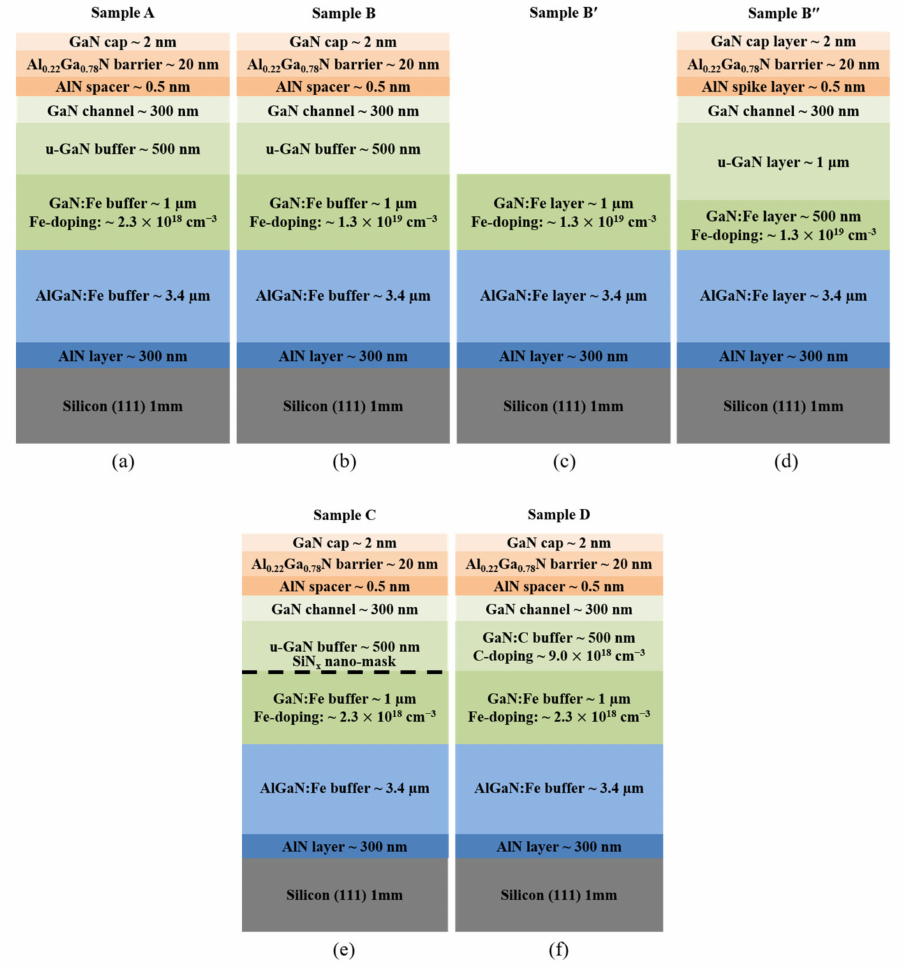
Figure 1. Schematic structures of Fe-doped GaN HEMT: ( a ) Sample A with Fe concentration 2.3 × 10 18 cm − 3 in the GaN:Fe buffer layer; ( b ) Sample B is the same as sample A, but with higher Fe concentration 1.3 × 10 19 cm − 3 ; ( c ) Sample B (cid:48) is the same as Sample B, but without the top layers; ( d ) Sample B (cid:48)(cid:48) is the same as Sample B, but with optimized thickness of GaN:Fe and u-GaN layers; ( e ) Sample C is the same as Sample A, but with a SiN x nano-mask; and ( f ) Sample D is the same as Sample A, but with carbon concentration 9.0 × 10 18 cm − 3 in the 500 nm LT GaN buffer